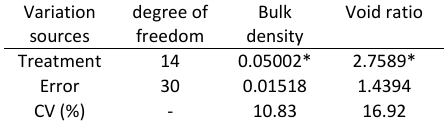
Table 5: ANOVA of the soil bulk density and void Table 5. ANOVA of the soil bulk density and void ratio under ratio under various treatments various Variation sources